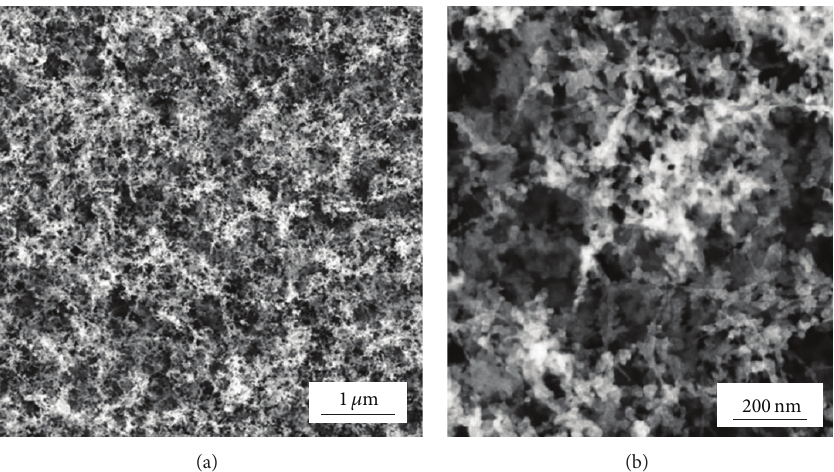
Figure 1: The typical SEM images of the film grown on the FTO; (a) and (b) are the low magnification image and high magnification image of the composite film,